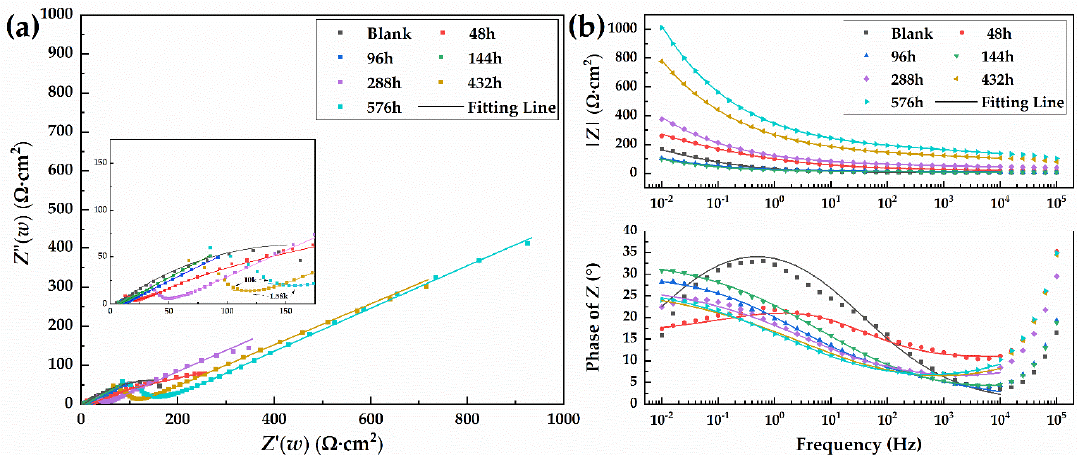
Figure 6. Nyquist plot ( a ) and Bode plot ( b ) of 30CrMnSiA steel for different corrosion periods.